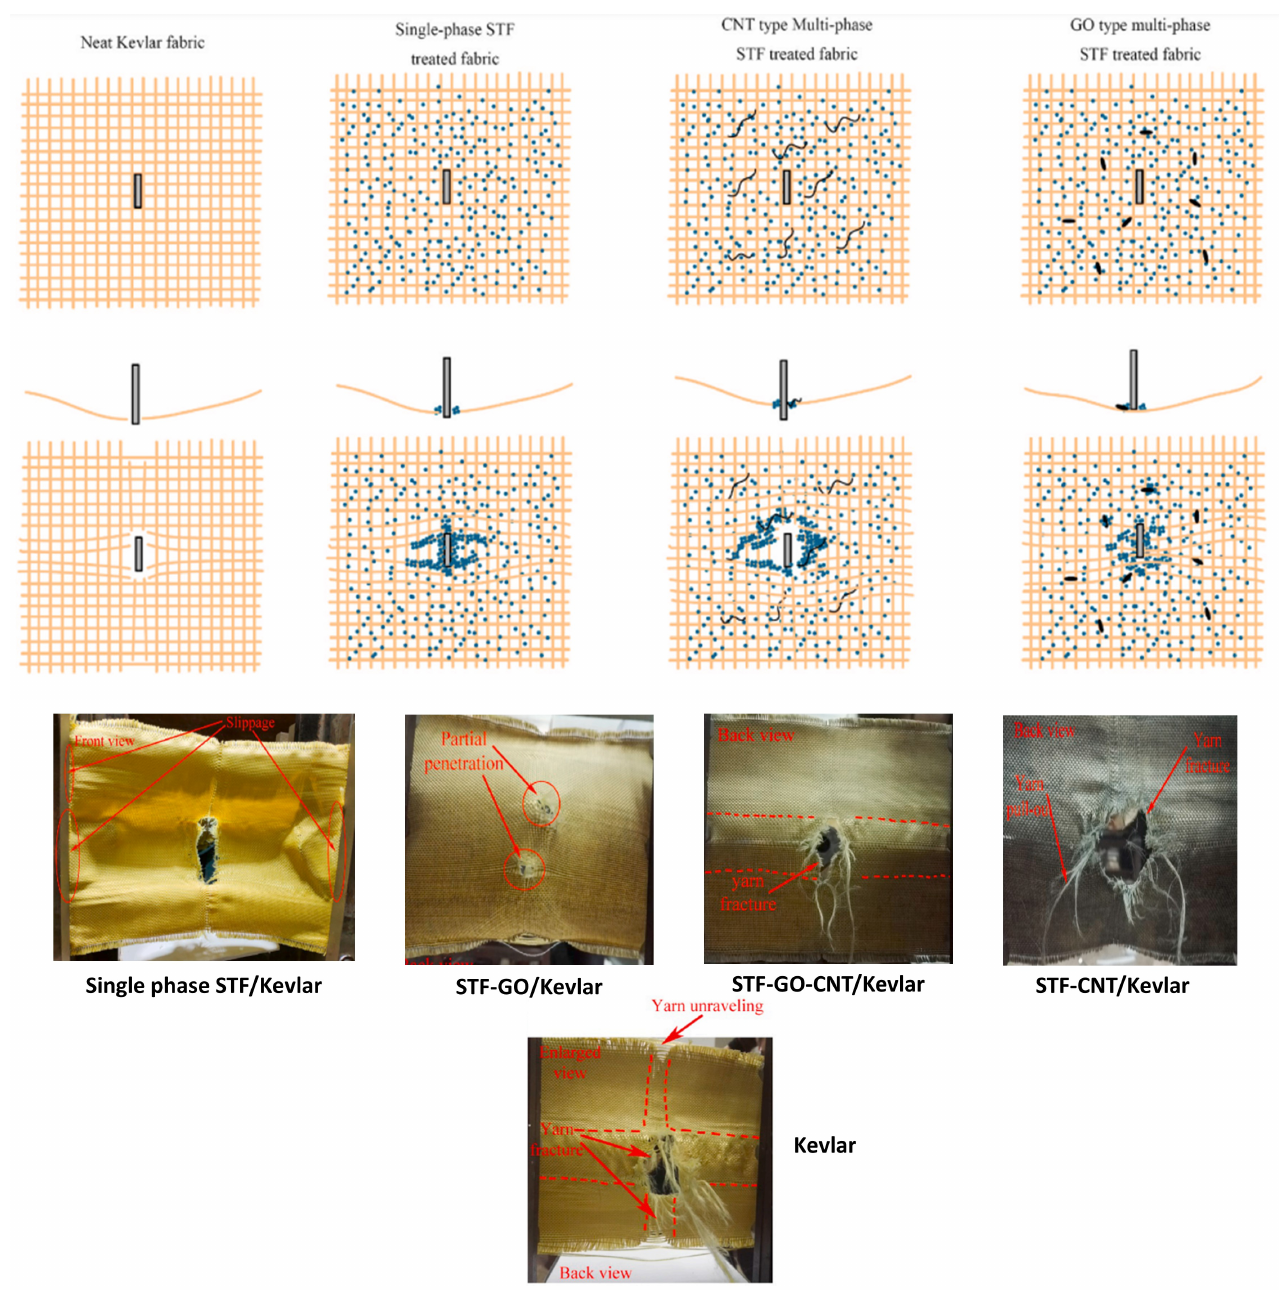
Figure 10. Schematic of the improvement mechanism of multi-phase STF treated fabric and damage visualization of single-phase and multi-phase STF-impregnated Kevlar fabrics after the ballistic test. Adapted with permission from Ref. [109]. Copyright 2022